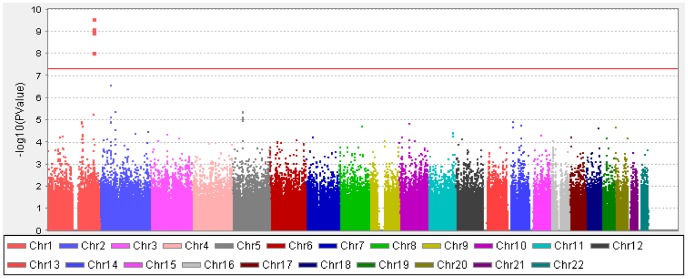
Manhattan plot of -log10(P) for the association on axial length from the meta-analysis in the combined cohorts of SCES, SCORM, and SiMES.The red horizontal line denotes genome-wide significance (P = 5×10−8).